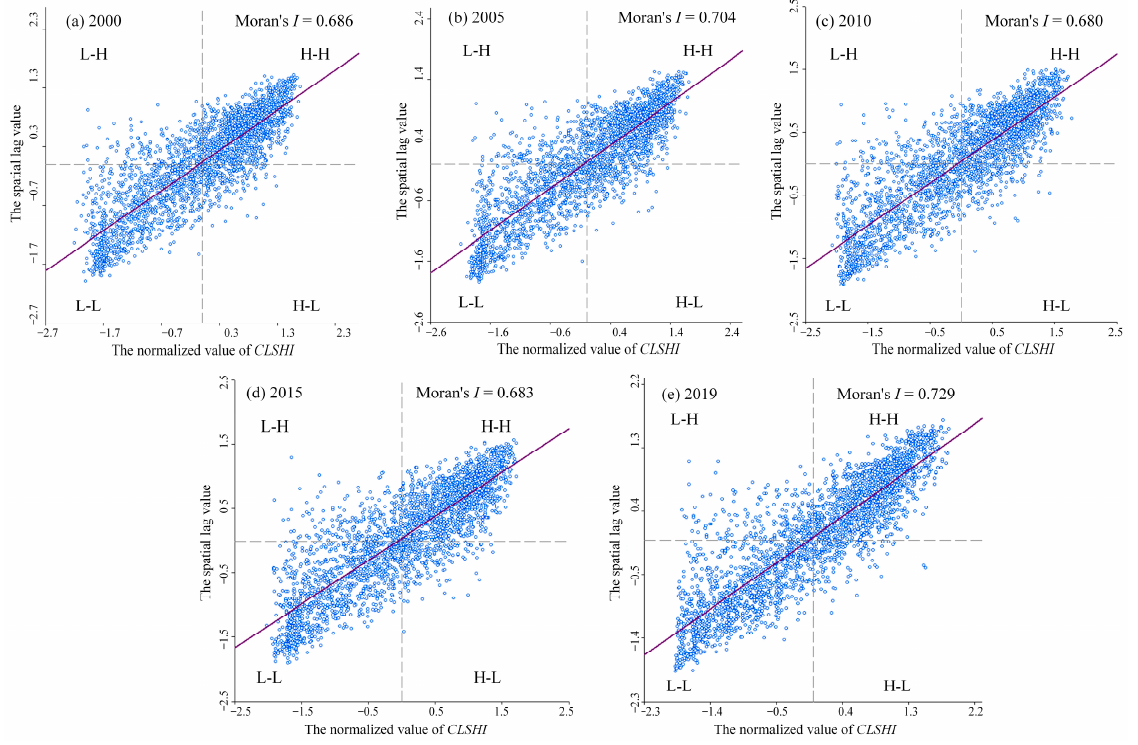
Figure 9. Moran’s I scatter diagram of CLSHI in the two lake plains from 2000 to